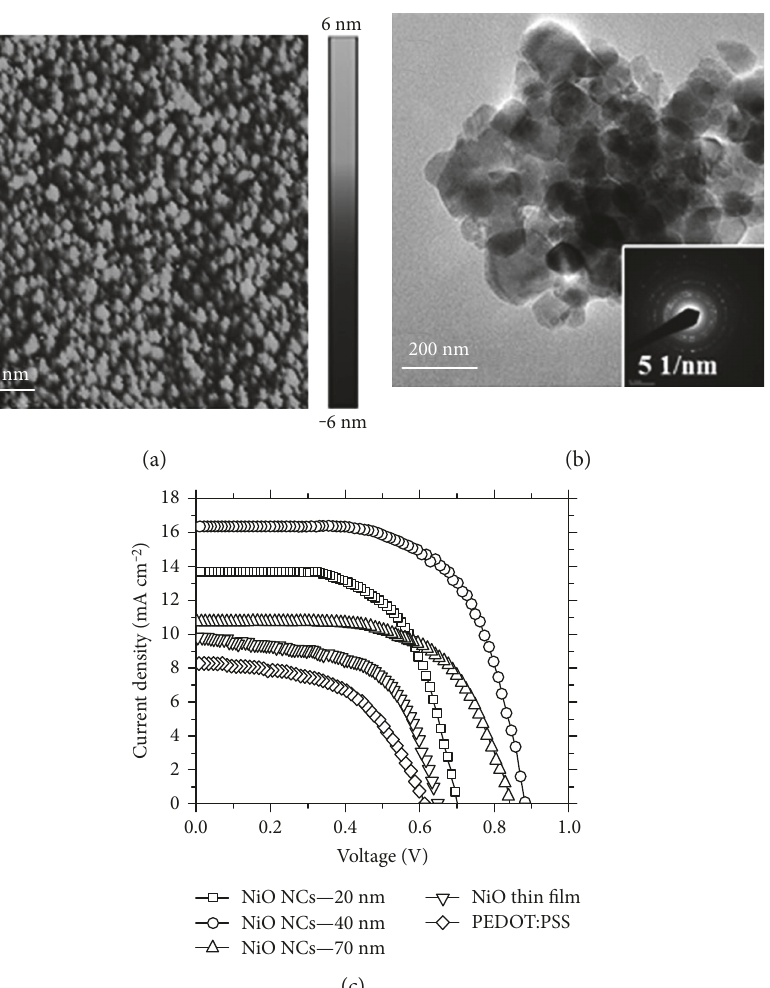
Figure 4: (a) AFM roughness image of a NiO nanocrystal fi lm on FTO. (b) Bright- fi eld TEM image of a sample of NiO NCs with the corresponding di ff raction pattern (inset). (c) Typical J – V curves of the perovskite solar cells with di ff erent NiO hole transport layers and PEDOT:PSS. Reprinted with permission from [25].